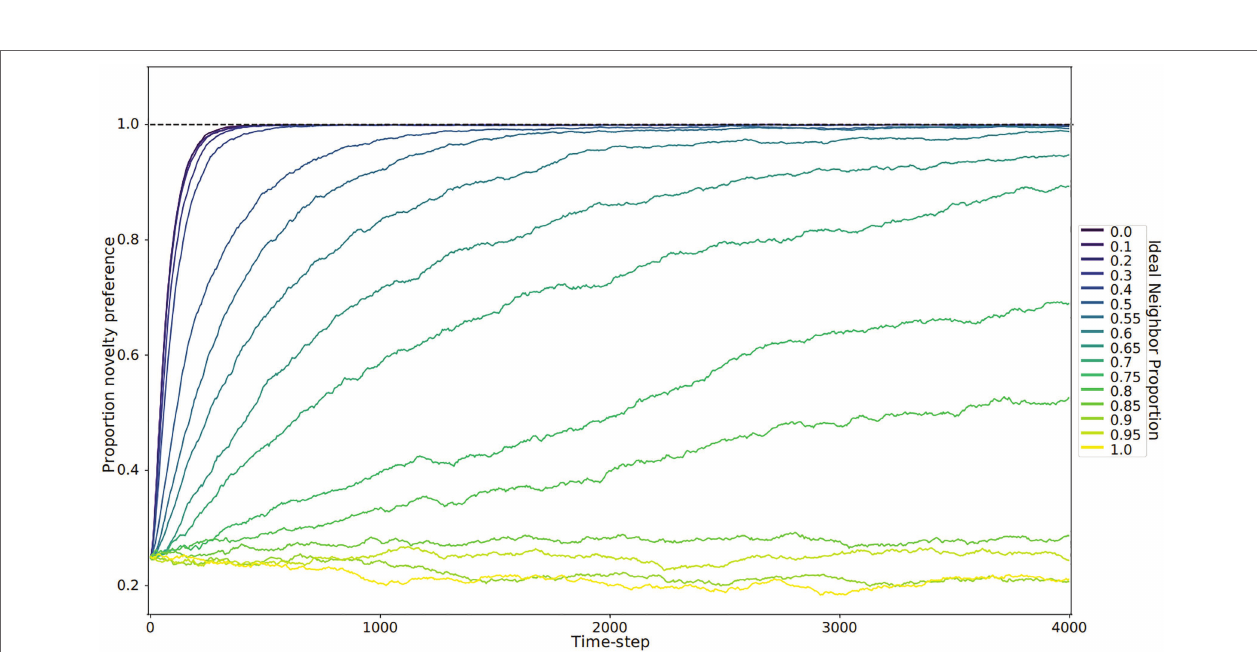
FIGURE 2 | Final fraction of novelty preference in the population after 4,000 iterations. Each population has a particular ideal neighbor proportion, representing the frequency of a cultural trait at which individuals have the highest fitness. As in Figure 1 , each of five replicates per ideal neighbor proportion are represented by a black point, with one standard deviation from the mean marked by red lines. Among populations with preferences for cultural conformity (ideal neighbor proportions between 0.85 and 1), the final proportion of novelty-biased learners does not deviate from its initial value of 0.25, suggesting little selective pressure. In contrast, populations with an ideal neighbor proportion below 0.5 exhibit strong selection pressure favoring novelty-biased learners, and this learning preference is nearly ubiquitous at the end of these simulations.